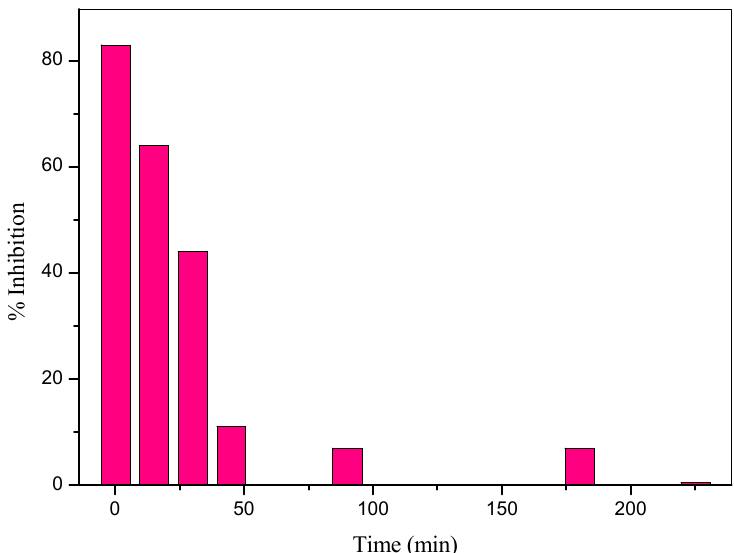
Figure 5. Change of the toxicity of a CLPR solution of initial concentration of 40 mg L − 1 during photocatalytic oxidation in the presence of photo-Fenton reagent (7 mg L − 1 Fe 3+ , 100 mg L − 1 H 2 O 2 ) and UV-A radiation.